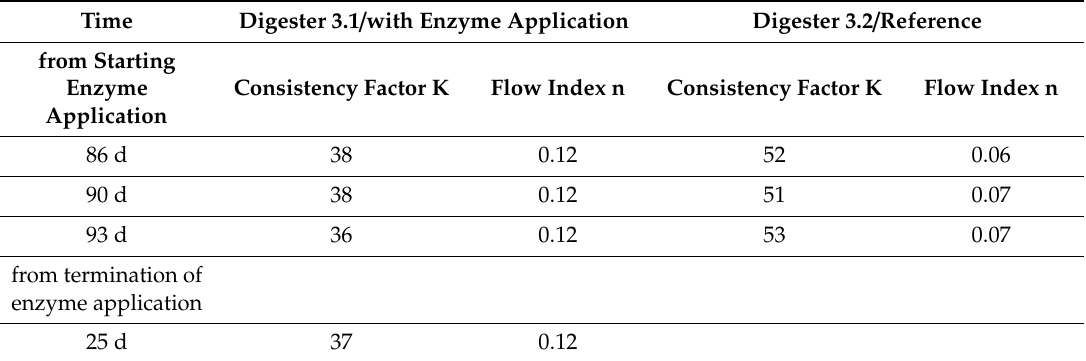
Table 5. Consistency factors and flow indices of the digestate from the treated and untreated digester at di ff erent times.